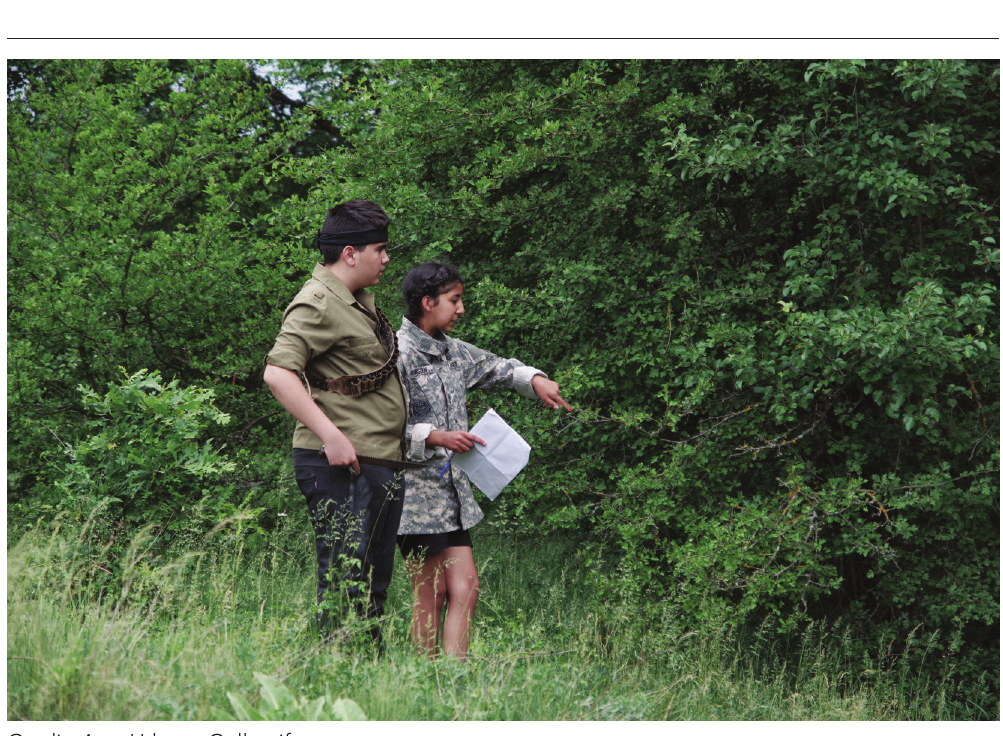
Figure 4: The shooting of 9 + 1 , filmed for CCAJ